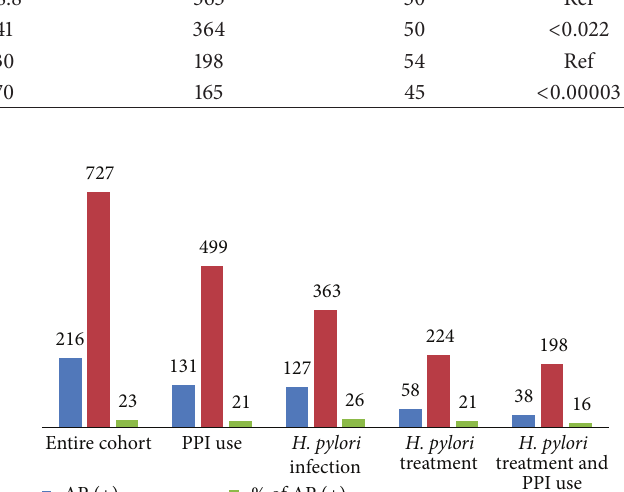
Table 3: Multivariate analysis of risk factors affecting development of adenomatous polyps in H. pylori -positive patients.